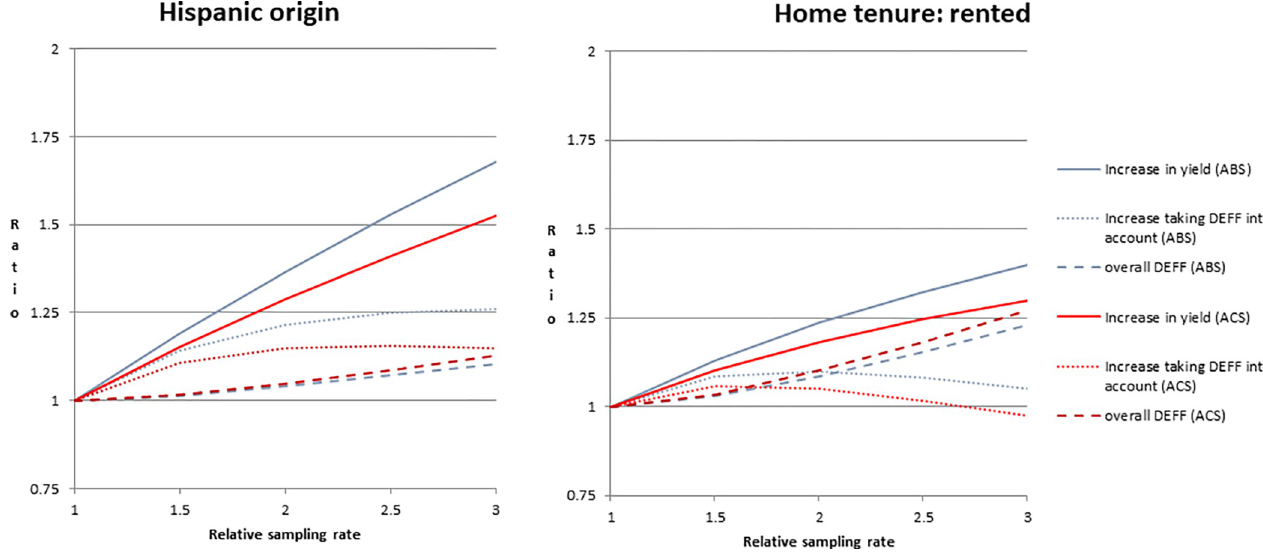
Fig 3. Effect of oversampling on yield, effective yield, and overall design effect (DEFF) for Hispanic origin and home tenure based on aggregated census tract-level data from the American Community Survey (ACS) in red and appended frame data (ABS) in blue.